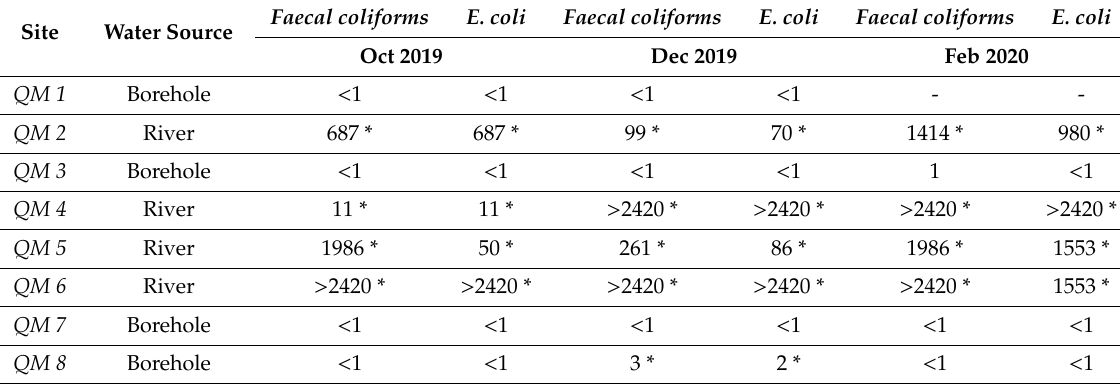
Table 6. Water analysis for faecal coliforms and E. coli bacteria contaminates (CFU / 100